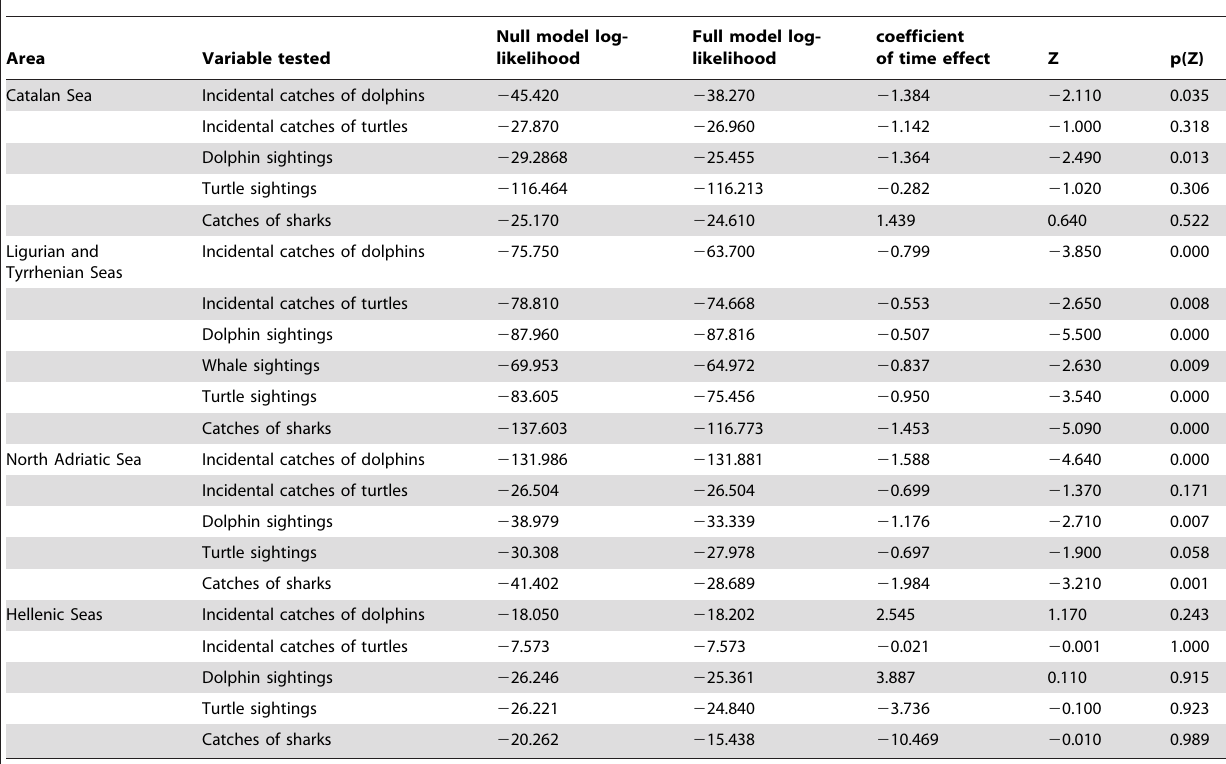
Table 2. Results of the Generalized Linear Mixed Models on ordinal outcomes in each study area.